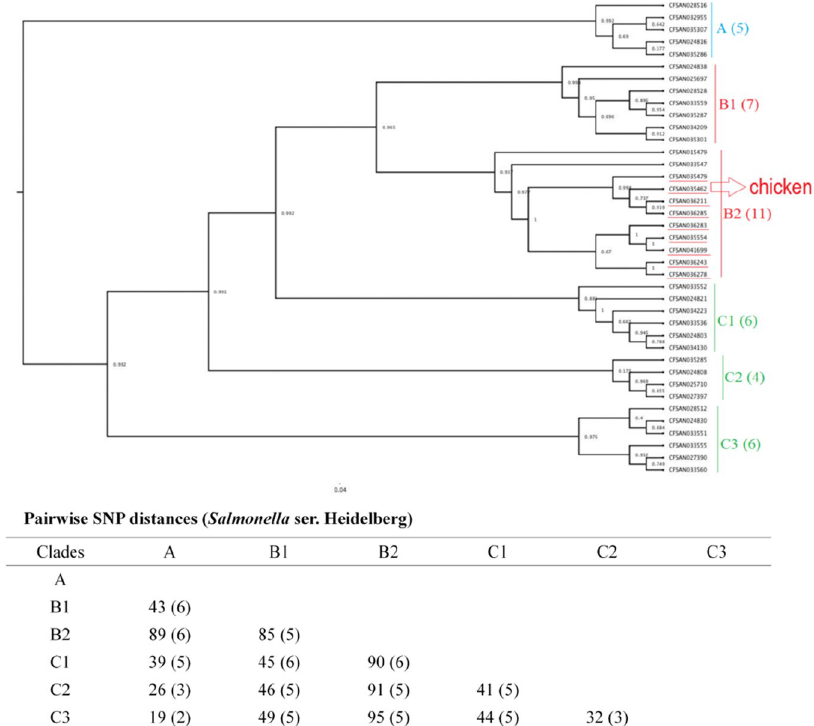
Figure 3. Phylogenetic tree of 39 Salmonella ser. Heidelberg isolates. Using core SNPs determined by FDA CFSAN SNP pipeline, the tree was constructed under the GTR-CAI model of FASTree 2. The analysis involved 19–95 total SNP positions. Clades and subclades are indicated in colors ( A , blue; B , red; and C , green) with numbers of total isolates in each clade or subclade in parentheses. Isolates sourced from chicken and clustered in subclade B2 are highlighted in red, the rest were from egg